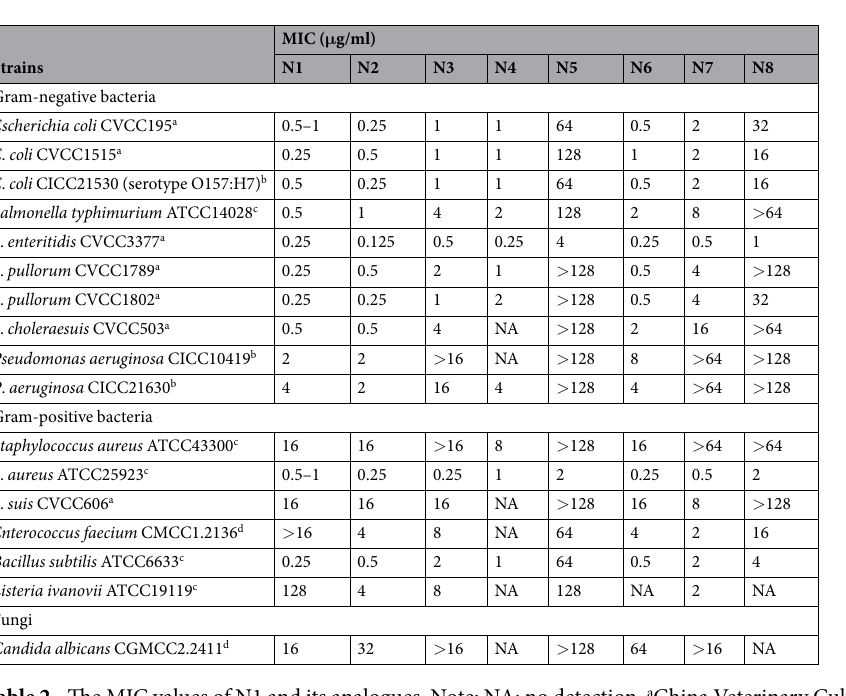
Table 2. The MIC values of N1 and its analogues. Note: NA: no detection. a China Veterinary Culture Collection Center (CVCC); b China Center of Industrial Culture Collection (CICC); c American Type Culture Collection (ATCC); d National Center Center for Medical Culture Collection (CMCC). Data were representative of three independent